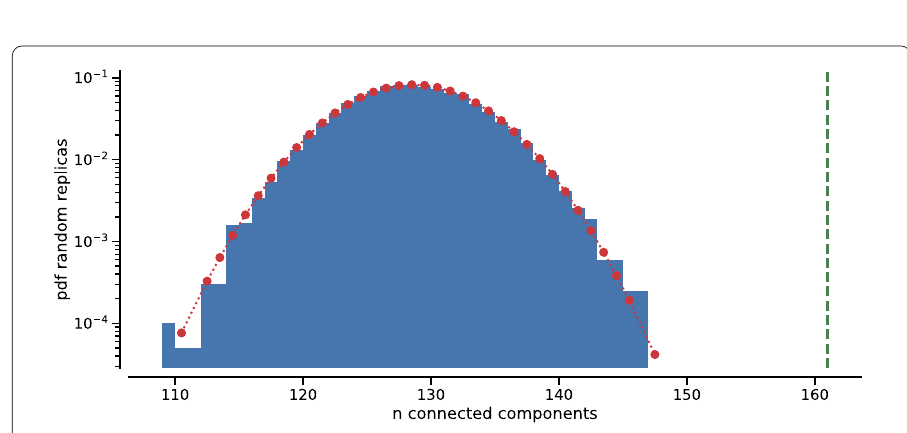
Figure 1 The green dashed vertical line shows the number of links between members of the same syndicate in the original network (198). The blue bars show the distribution of the same quantity extracted from an ensemble of random replicas of the network that preserve the degree distribution. The distribution is obtained over 10,000 iterations